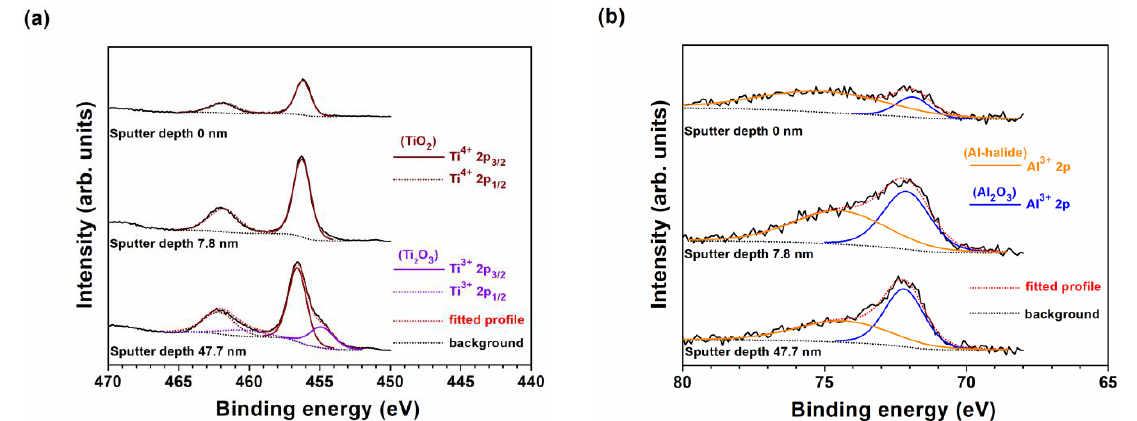
Figure 9. XPS analysis results of ( a ) Ti and ( b ) Al profiles at depths of 0, 7.8, and 47.7 nm of the Ti-6Al-4V substrate after immersion in Ringer’s solution for eight